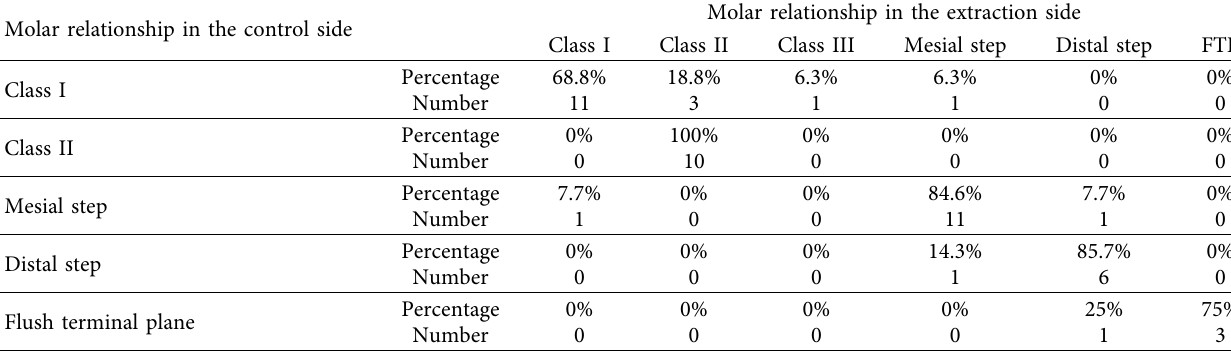
Table 5: Comparison of the molar relationship between the extraction and control sides.